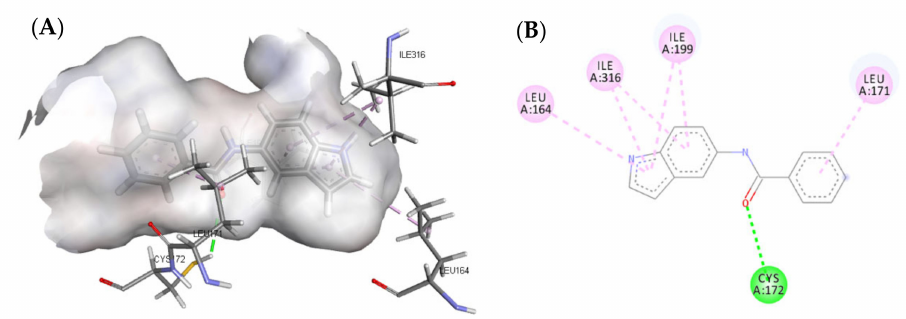
Figure 4. ( A ) Three-dimensional (3D) representation of the interactions of compound 3a with MAO-B; ( B ) Two-dimensional (2D) interaction model compound 3a with